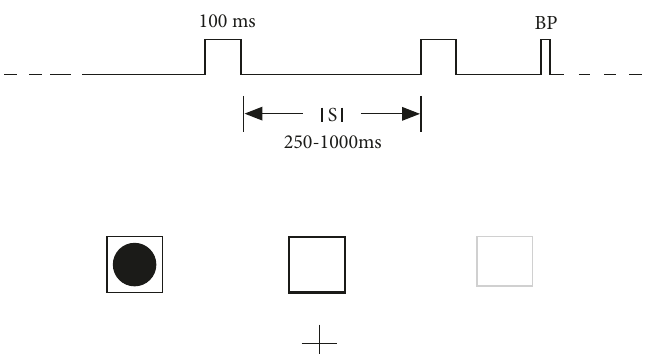
Figure 1: Schematic view of the experiment design (BP: button press; ISI: interstimulus interval; fi lled circle stands for stimuli; lightly shaded box stands for the attended